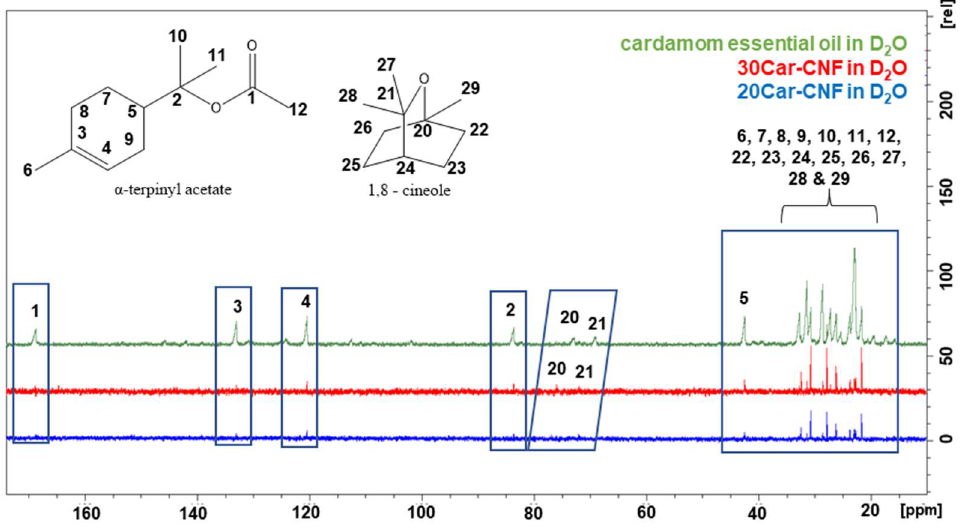
Figure 8. 13 C spectra of EO Cardamom essential oil ( Elettaria cardamomum , CAS Number 8000-66-6), 30Car–CNF emulsion, and 20Car–CNF emulsion diluted with D 2 O.